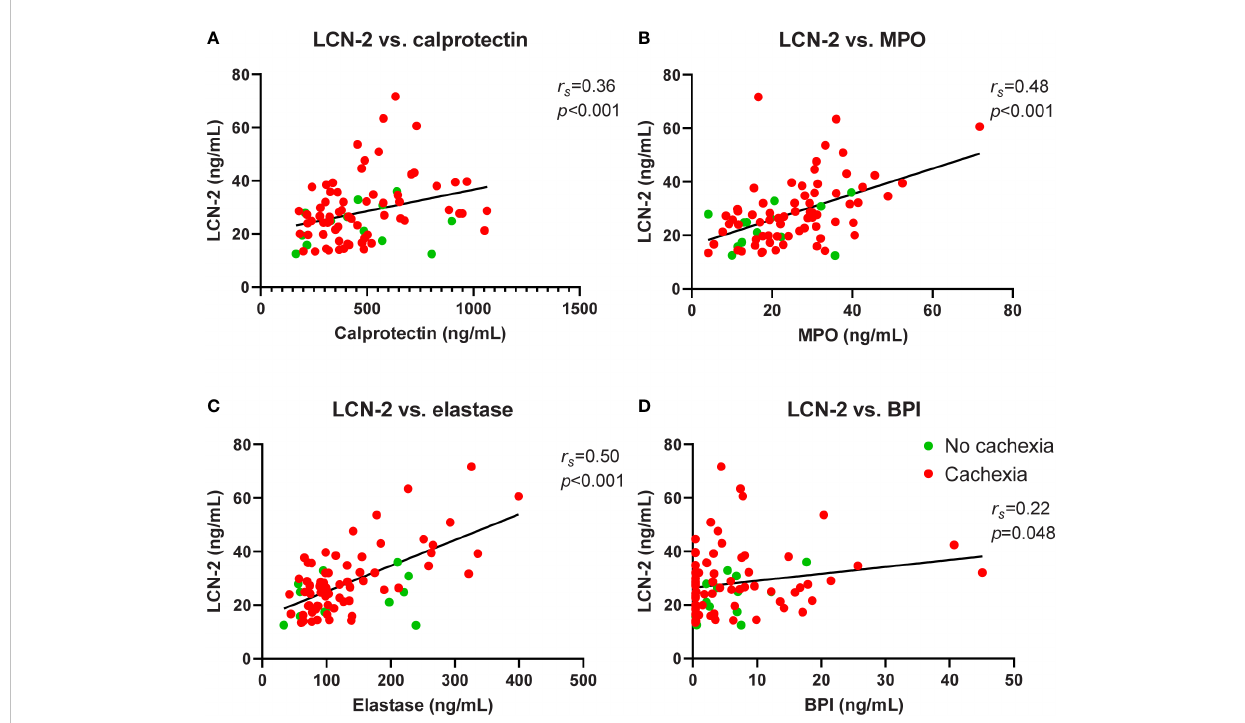
FIGURE 3 Correlation analysis of circulating LCN-2 and neutrophil activation markers in PDAC patients. Systemic levels of LCN-2 were positively correlated with levels of calprotectin (A) , MPO (B) , elastase (C) , and BPI (D) . Spearman ’ s rank correlation coef fi cient ( r s ) and level of signi fi cance are indicated in the respective plots.